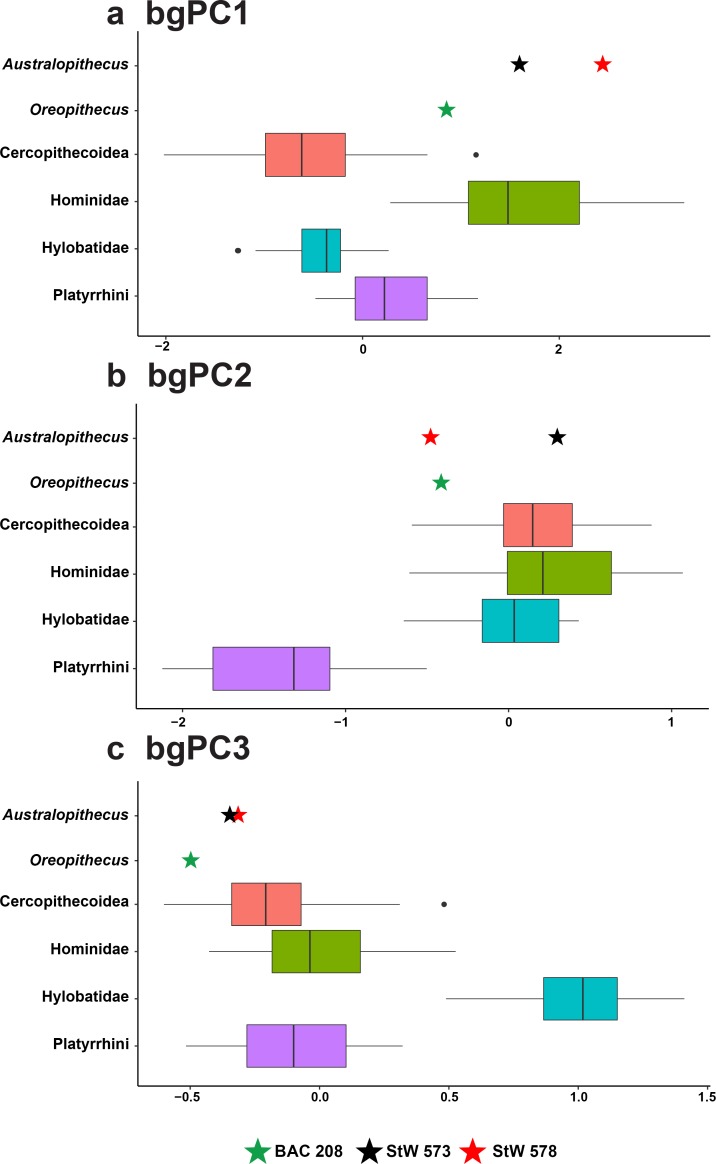
Box-and-whisker plots of the principal components (bgPCs) from the between-group principal components analyses (bgPCA) of vestibular shape for the anthropoid sample.(a) bgPC1; (b) bgPC2; (c) bgPC3. Colored stars correspond to: green, Oreopithecus; black, Australopithecus sp. (StW 573); red Australopithecus sp. (StW 578).